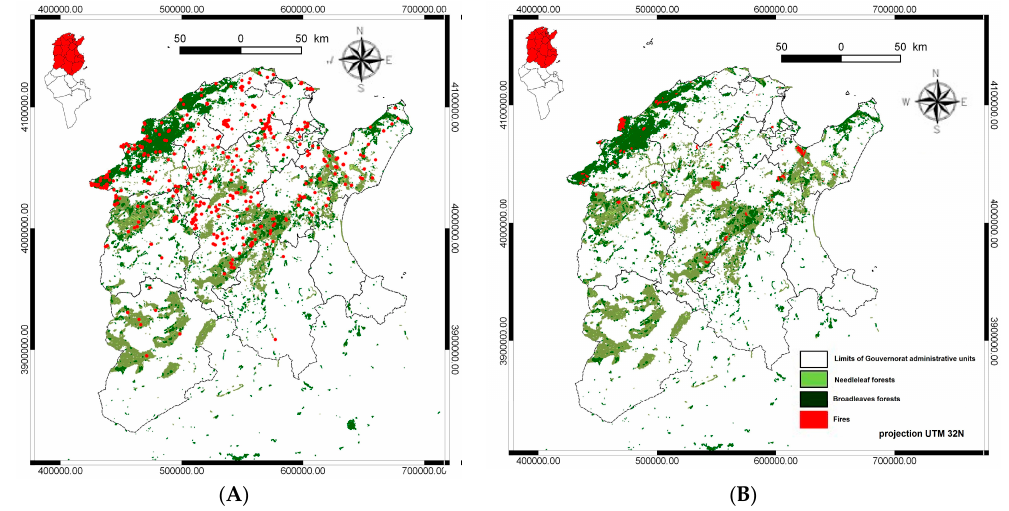
Figure 7. Location of fire events larger than 4 ha in Tunisia from the COR-1 database (red dots) ( A ); Fire contours (red polygons for fires larger than 4 ha) in Tunisia obtained from the Landsat image analysis over the period 1985–2010 ( B ). Background information refers to the needleleaf and broadleaf forests in Tunisia based on the Tunisian Forest Inventory [49].